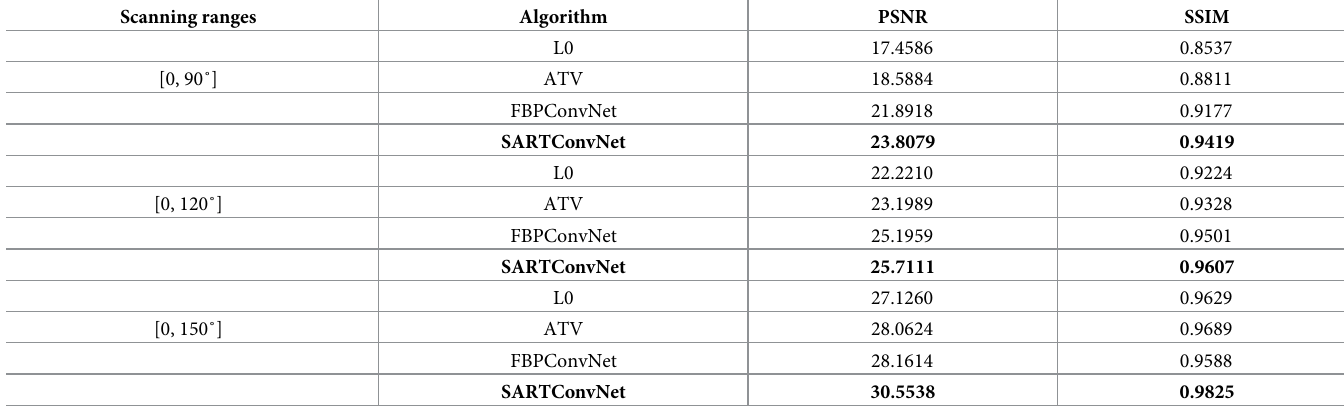
Table 3. Quantitative results associated with different algorithms for the chest image from different angle projection data. Scanning ranges